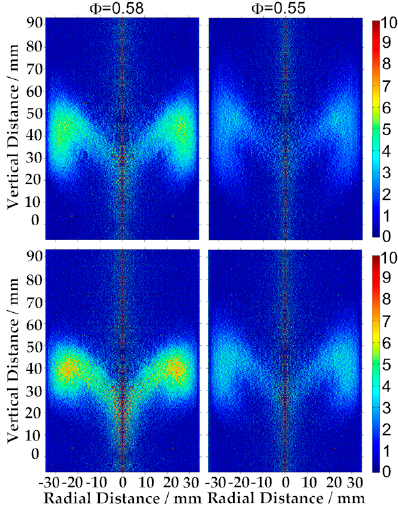
Figure 16. Evolution process of OF30-1 (upper row) and CH4/air (lower row) flames when the equivalence ratio is close to the lean blowout limit for a preheating temperature of 466.15 K.